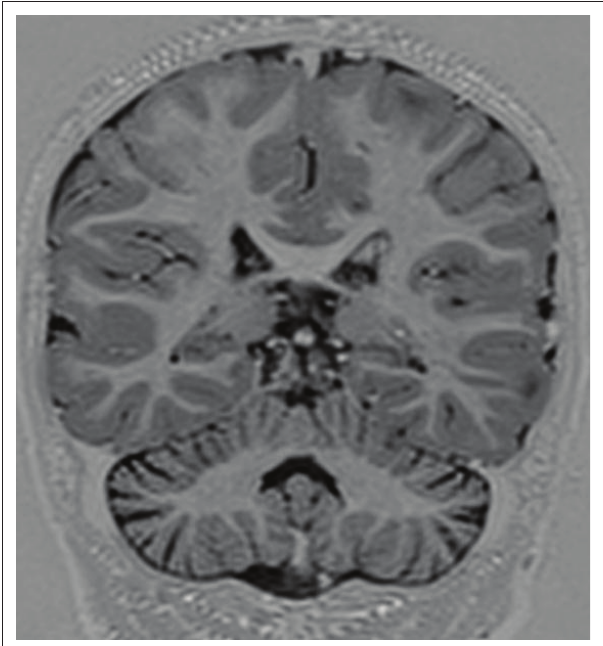
FIGURE 4: Coronal T1-inversion recovery MR